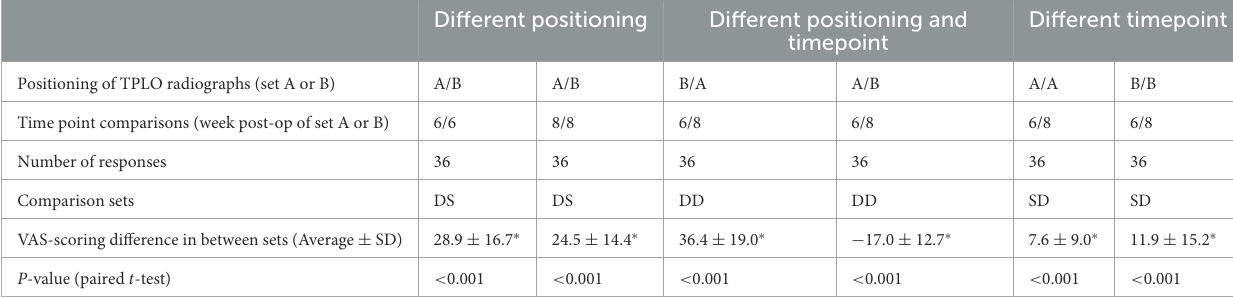
TABLE 3 Comparison of the influence of positioning and actual healing on osteotomy scoring for patient #1 illustrating that different positioning of TPLO-radiographs results in greater magnitude of changes to the VAS-scoring than the observed amount of healing. Different positioning Different positioning and Different timepoint